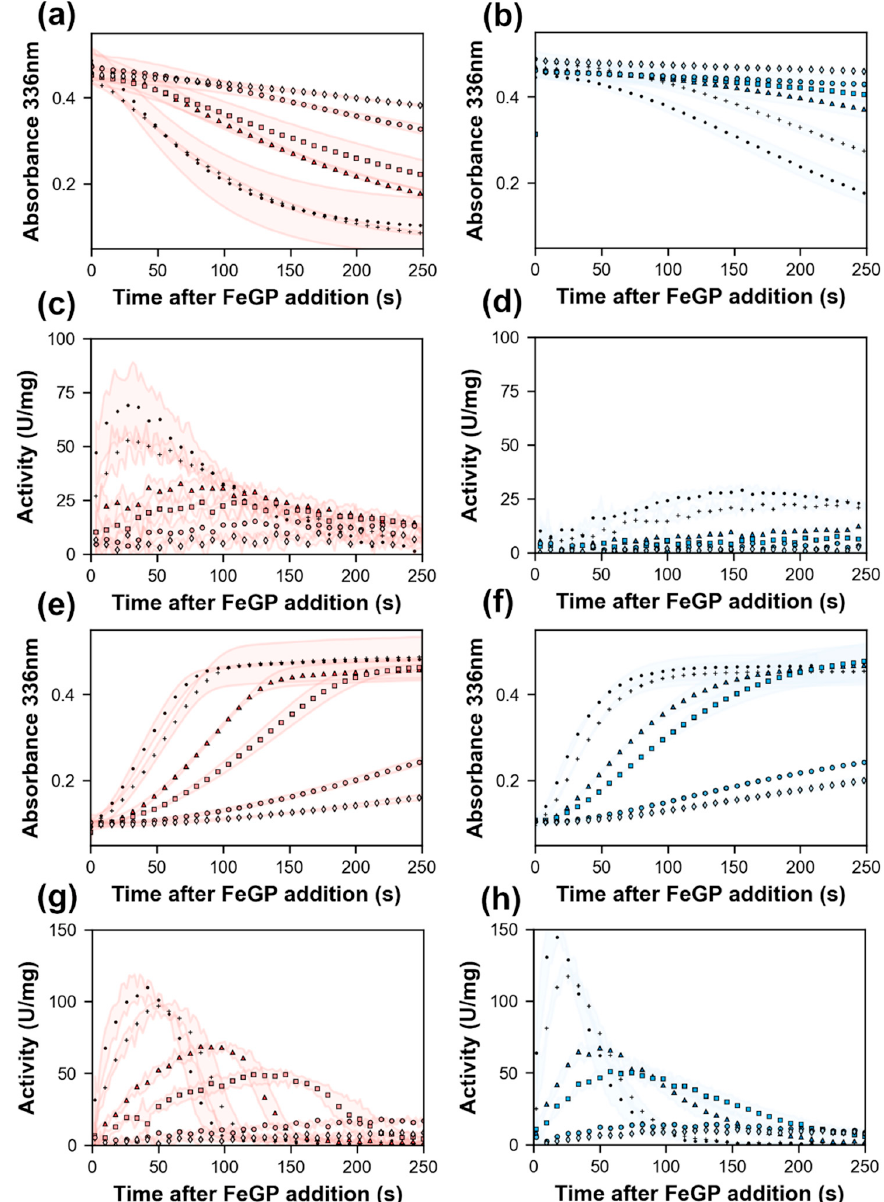
Figure 6. Reconstitution of the [Fe]-hydrogenase holoenzyme from the apoenzyme of the wild-type ( a , c , e , g ) and Lys150Ala variant ( b , d , f , h ) with the FeGP cofactor. Changes of the absorbance at 336 nm according to the reduction of methenyl-H 4 MPT + ( a , b ) and oxidation of methylene-H 4 MPT ( e , f ) were recorded. The color area indicates the standard deviation of three tests. The enzymatic activity (U/mg) ( c , d , g , h ) of each 2 s was calculated from the data of ( a , b , e , f ), respectively. Concentrations of the FeGP cofactor were 700 (•), 350 (+), 100 ( ∆ ), 50 ( □ ), 10 ( ○) and 4 nM ( ◊ ). The plots of the data of the wild type and the Lys150Ala variant are shown in red and blue, respectively.